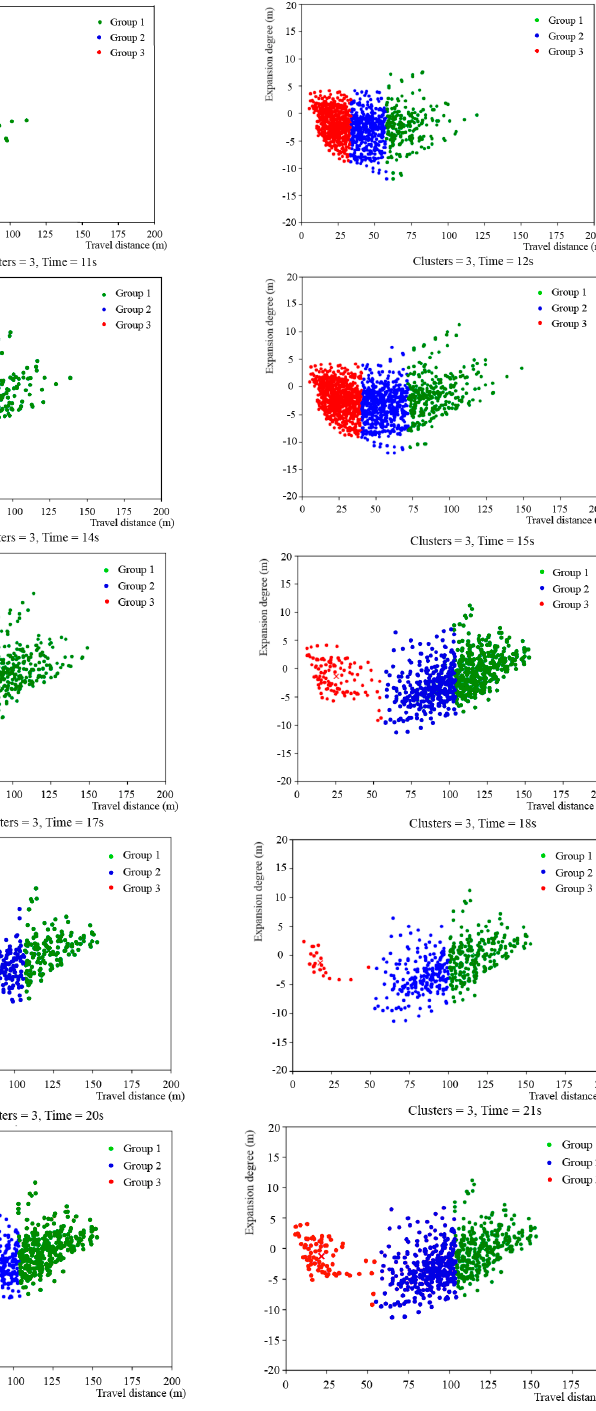
Figure 4. E-bike spacing cluster map for 0–21 s of the northwest entrance road at the intersection of Longpan Road and Bancang Street.